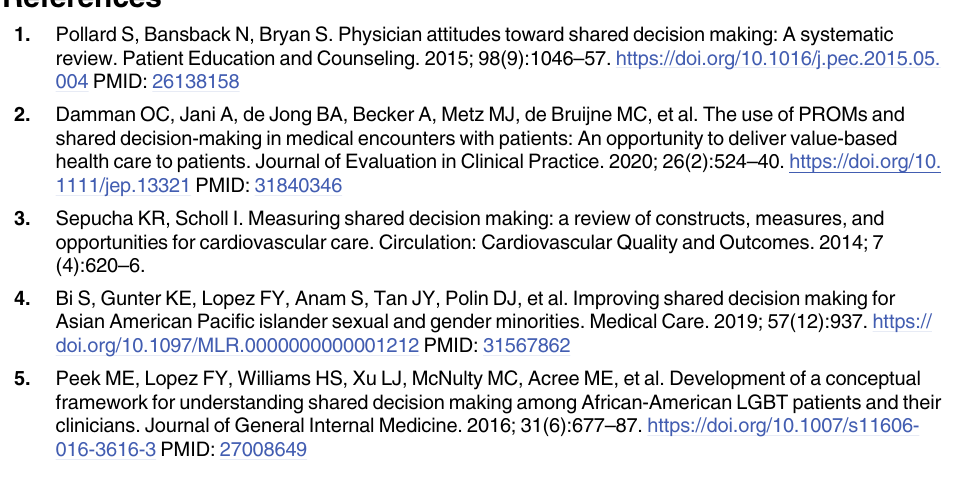
S1 Table. Output of the inferential